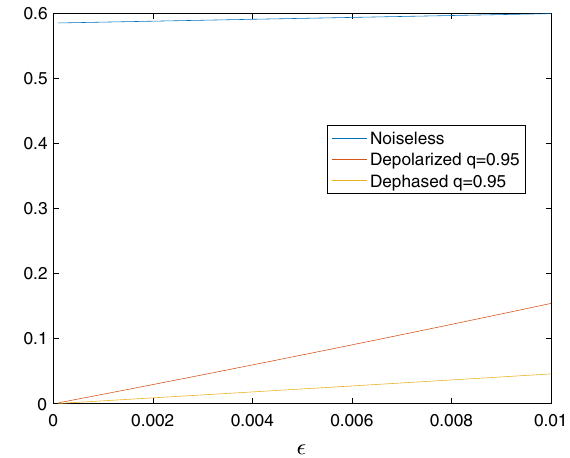
FIG. 10. Plot of ε -hypothesis-testing upper bound on the conference key rate for a single copy of the Φ W 3 state, for noiseless, dephased, and depolarized